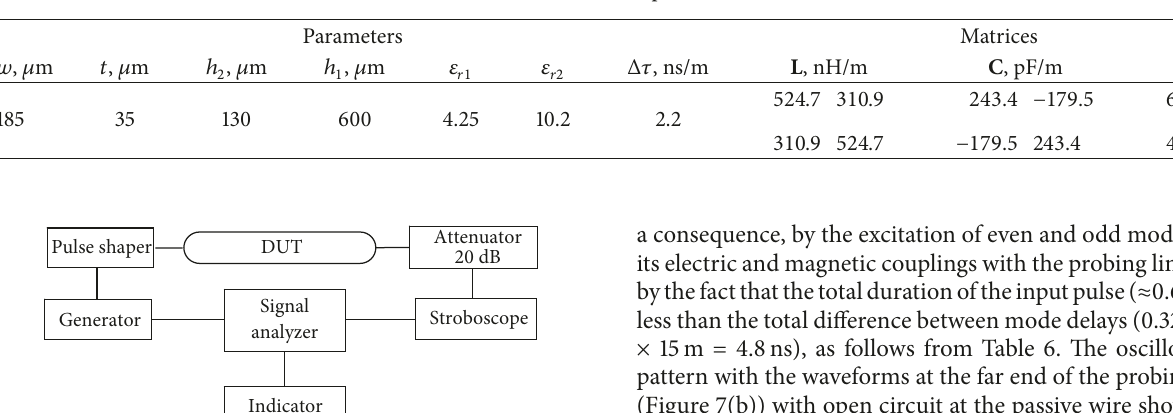
Figure 3: The cross section of the experimental PCB (a); photography of the experimental PCB with the scalar network analyzer P2M-40 connected to it (b). Table 2: Parameters of the experimental structure.